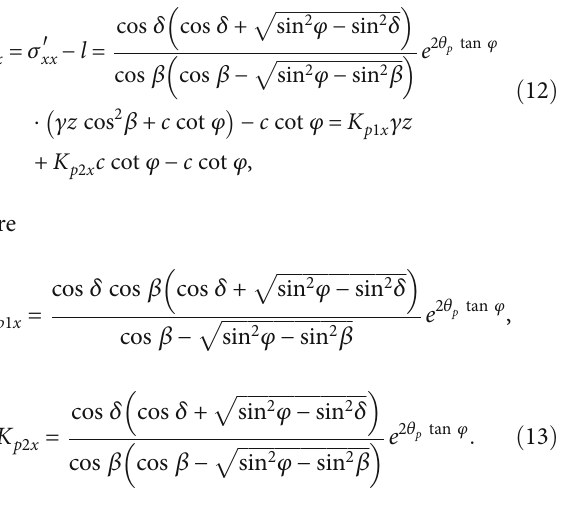
ffiffiffiffiffiffiffiffiffiffiffiffiffiffiffiffi